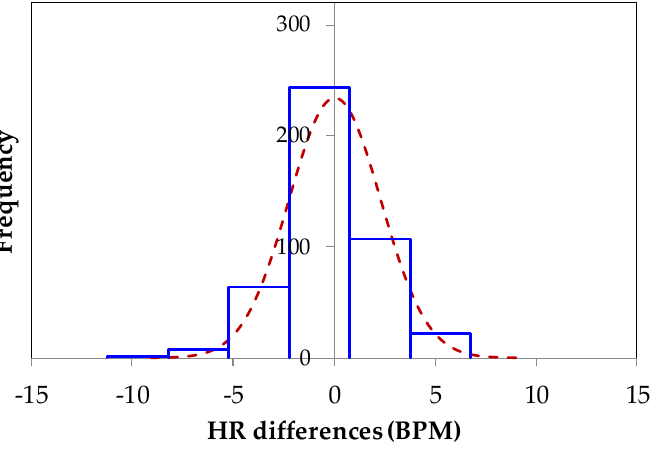
Figure 9. Histogram of the peak-to-peak differences between the HR measured by the DIC and by the commercial monitor.